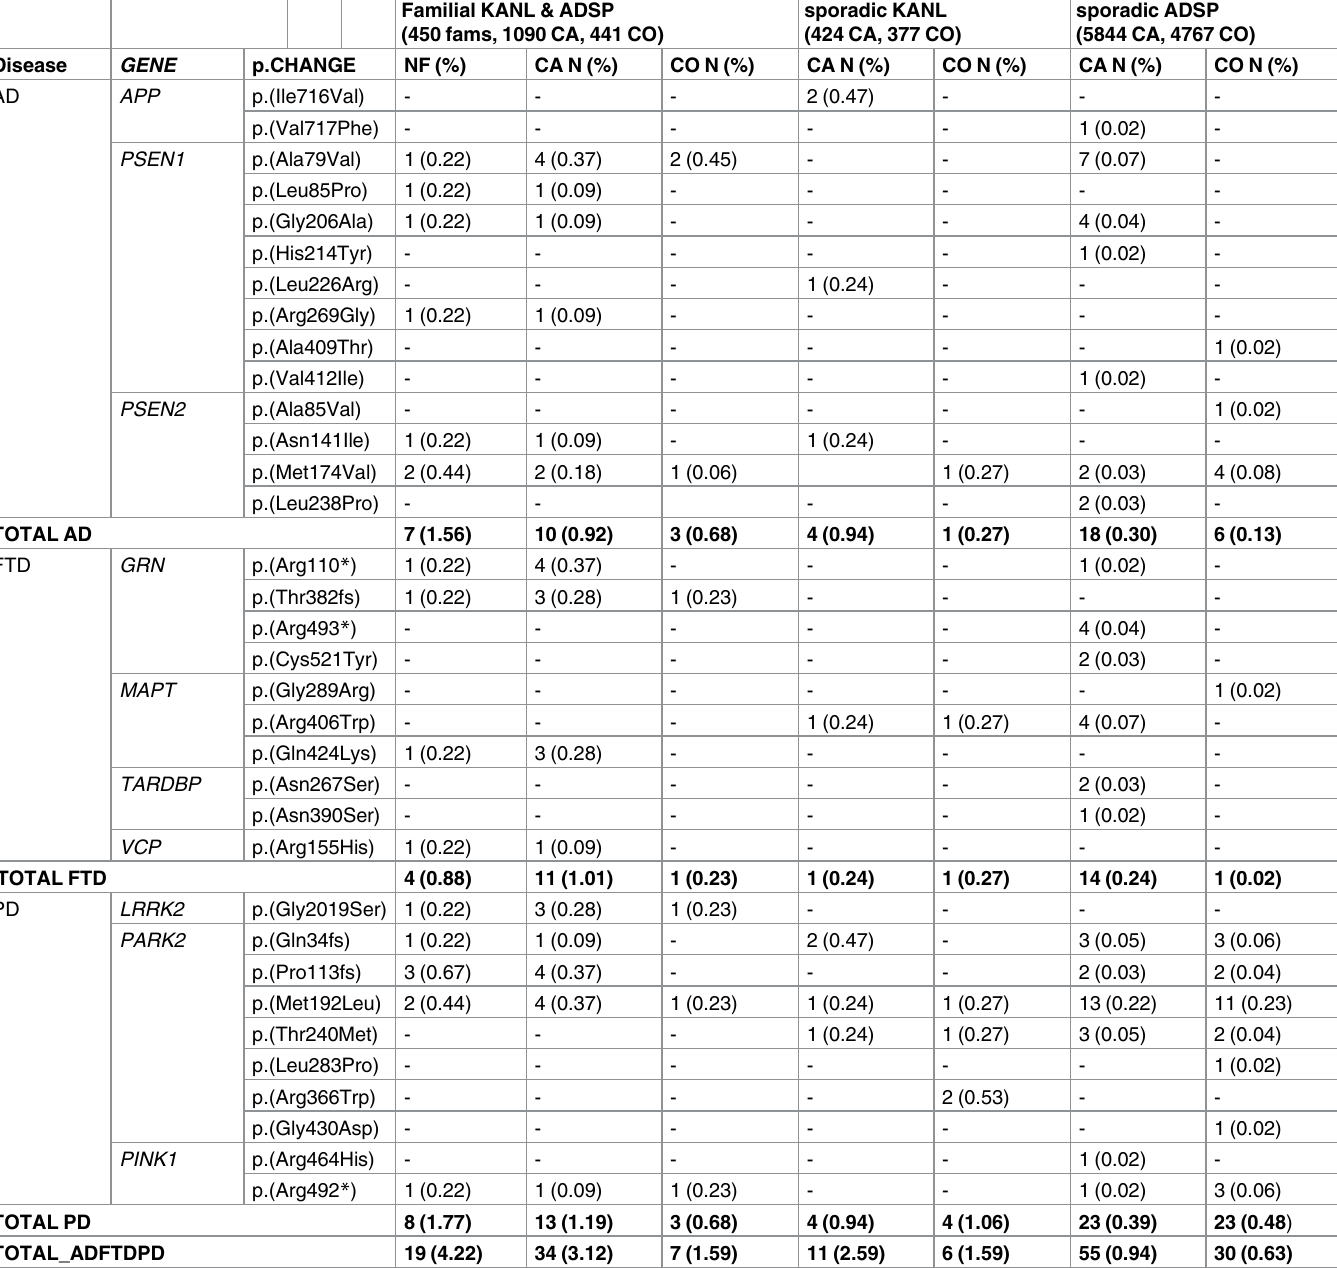
Table 1. List of reported * pathogenic variants in genes for Alzheimer disease (AD), Frontotemporal dementia (FTD) and Parkinson disease (PD) detected in the familial cohort, the sporadic KANL cohort and the ADSP sporadic cohort. We provide the numberand percentageof families (NF), cases (CA) and controls (CO) that were carriers of each